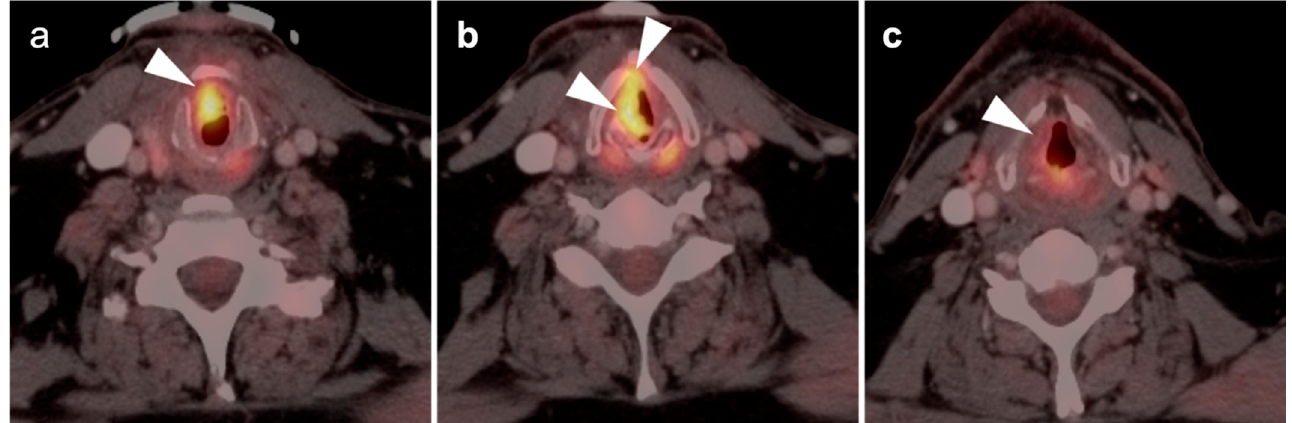
Figure 19. Squamous cell carcinoma of the glottis (true cord). A hypermetabolic tumor of the true cords is shown on axial FDG PET ‐ CT images. ( a ) The lesion involves the anterior commissure (white arrow); ( b , c ) The tumor involves the entire right true cord white arrowheads).